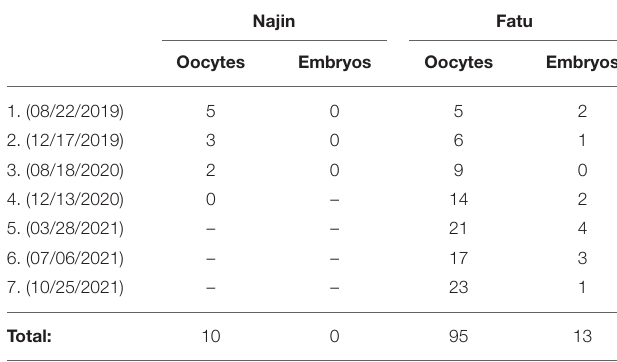
TABLE 3 | Results of OPU and ICSI on